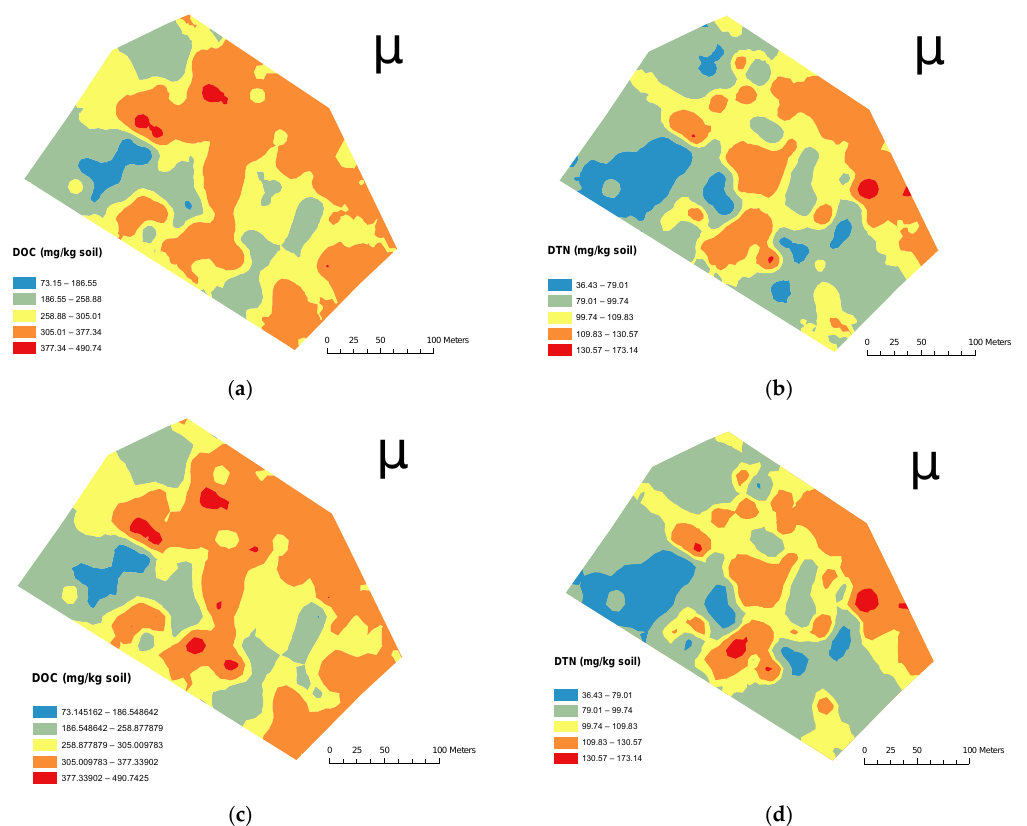
Appl. Sci. 2021 , 11 , x FOR PEER REVIEW